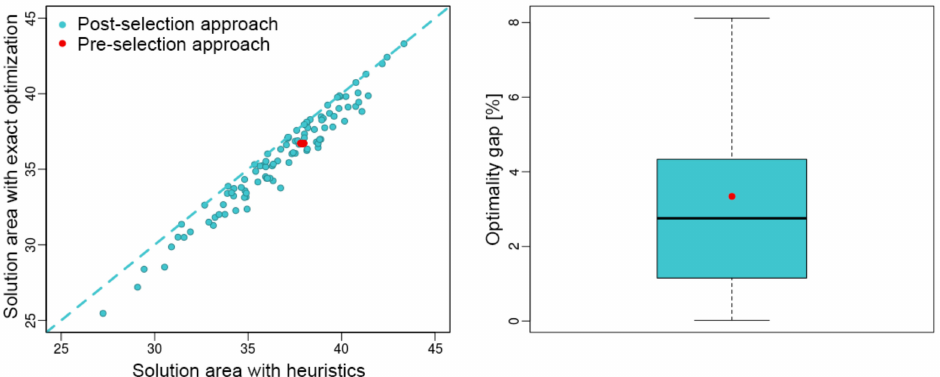
Figure 5. Left: scatter plot showing the area of conservation solutions (expressed as percentage of the sea) for random-based heuristics and optimal conservation outcomes for both the pre-selection and post-selection approaches; each point represents the percentage of protected areas necessary to achieve species target. Right: boxplot of optimality gap between sub-optimal and optimal conservation outcomes for each ‘distribution scenario’. The gap between the best Marxan solution and the optimal solution based on the pre-selection approach is shown by a red